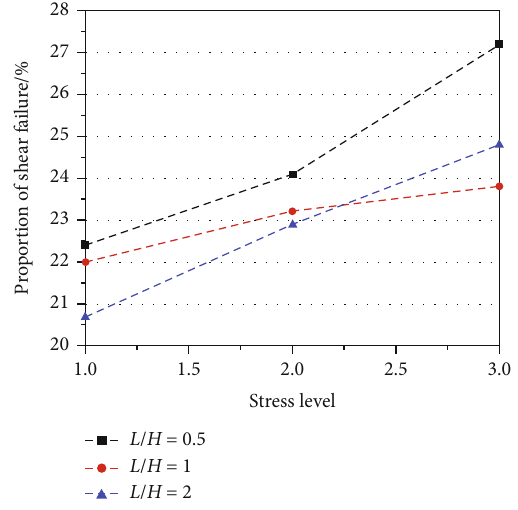
Figure 4: Proportion of shear fractures in rock